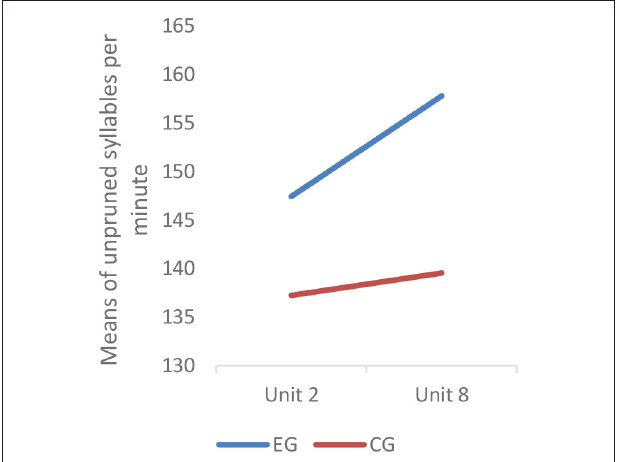
FIGURE 6 | Profile plotsof lexical accuracy. Covariates appearing in the model are evaluated at the following values: placement test score = 83.05.